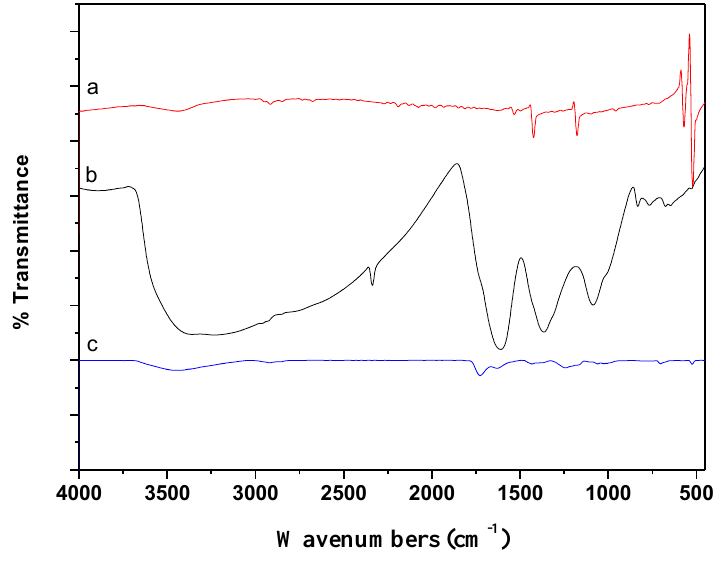
; ( b ) C (OH) ; ( c ) C (C(COOH) 60 60 n 60